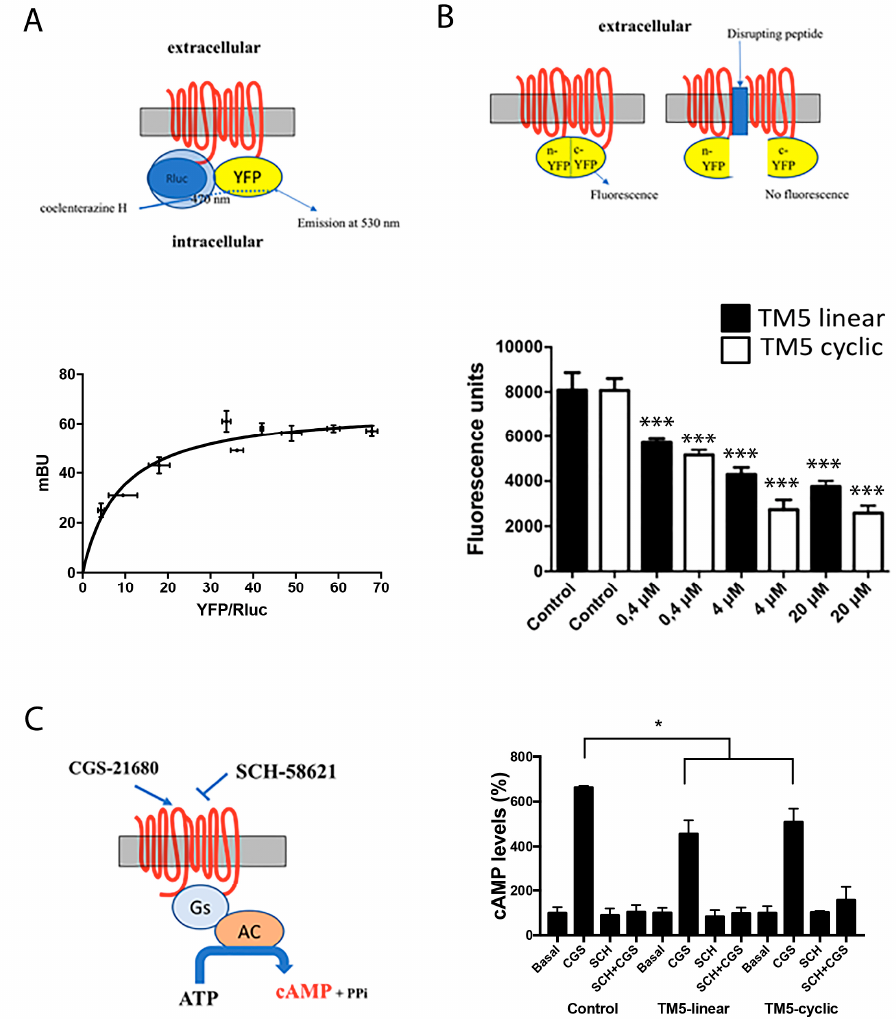
Figure 2. Bioluminescence resonance energy transfer (BRET) assays for homodimer receptor identification and bimolecular fluorescence complementation and signaling in cells expressing A 2A receptors in the presence of linear and cyclic Tat-like (disrupting) peptides 1 (linear TM5-Tat) and 2 (TM5-cyclic Tat-like). A scheme of BRET ( A ), molecular complementation ( B ) and cAMP determination ( C ) assays is shown close to each graph; AC = adenylyl cyclase. Panel A: data are mean +/ − standard deviation (SD, n = 6 in duplicates). The blue arrow in the upper illustration denotes that, only if dimerization occurs, energy transfer from RLuc to coelenterazine H takes place, causing YFP excitation hence fluorescence emission. Panel B: data are mean +/ − SD ( n = 12 in duplicates); *** p < 0.001 respect to each control (analysis of variance (ANOVA) followed by Bonferroni’s post-hoc tests). Panel C: data are the mean (in % of increase over basal) +/- SD ( n = 8 in duplicates). * p < 0.05 with respect to absence of peptides and no significant differences in linear versus cyclic by two-factor ANOVA analysis.